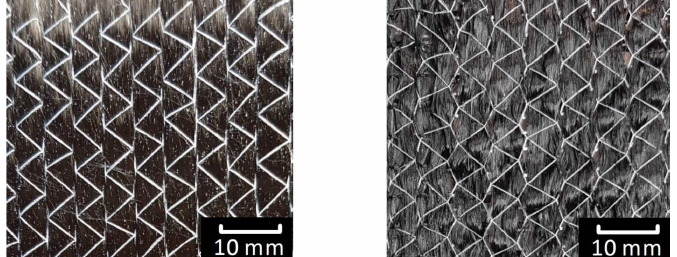
Figure 12. Undeformed fabric ( left ), fabric with gaps: roving becomes wider and the angle of the stitching yarn becomes sharper ( right